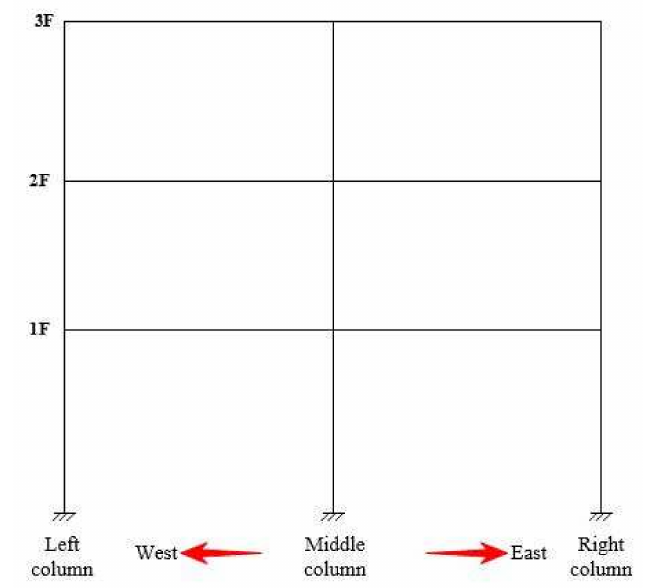
Figure 7. Phenomenon description